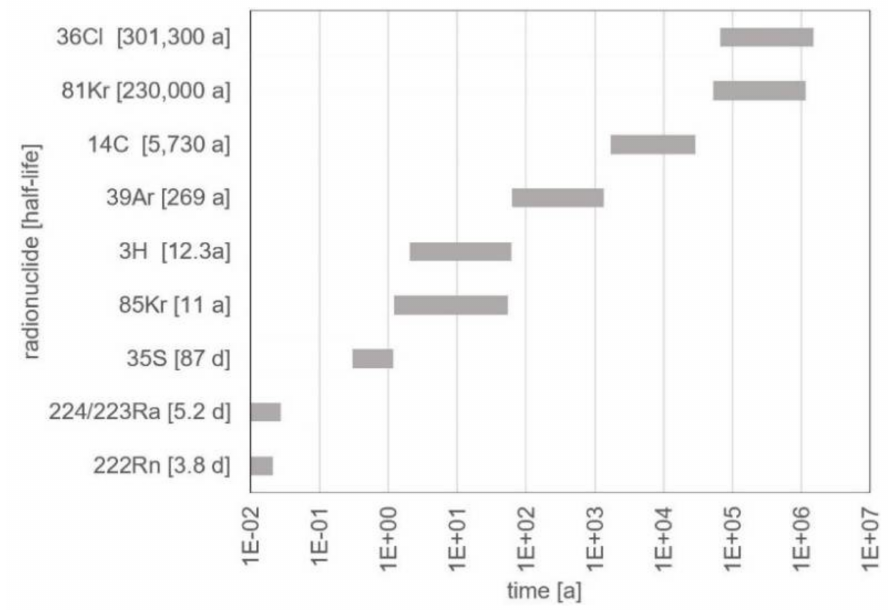
Figure 2. Radionuclides suitable as age tracers versus approximately covered age